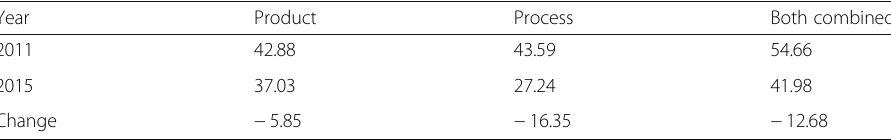
Table 4 Percentage of enterprises with innovation in the two surveys Year Product Process Both combined 2011 42.88 43.59 54.66 2015 37.03 27.24 41.98 Change − 5.85 − 16.35 − 12.68